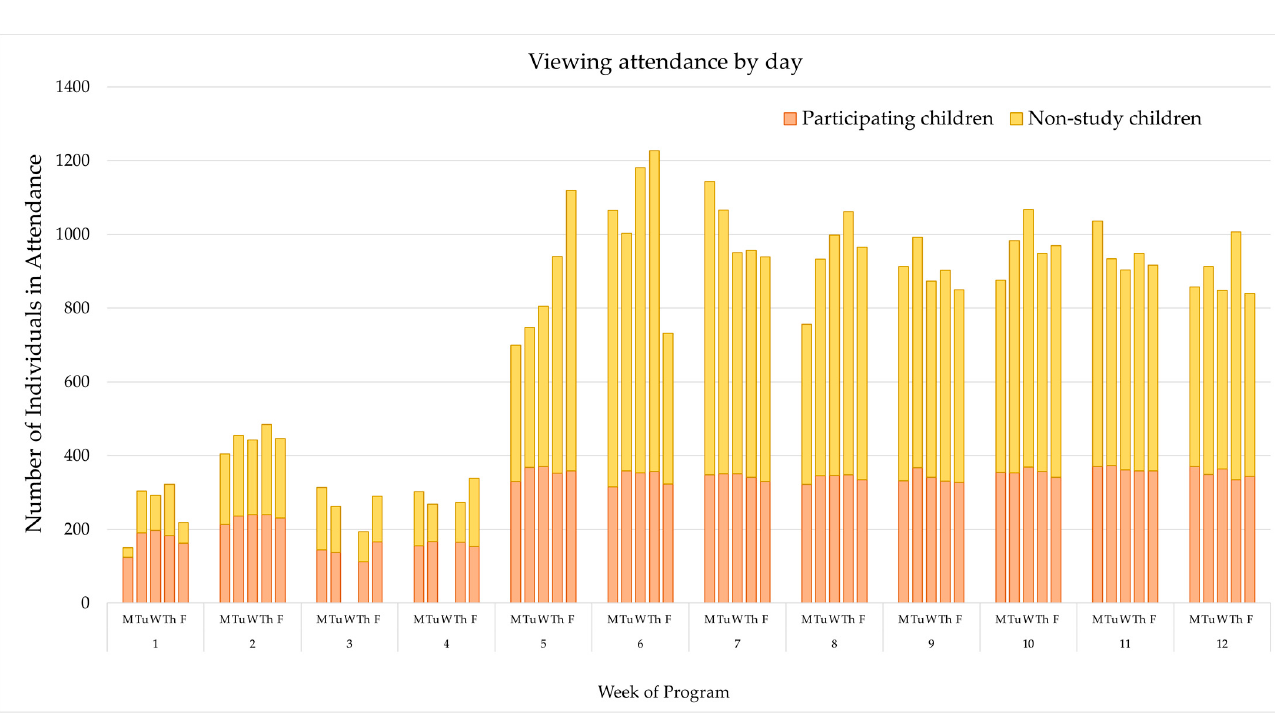
Figure A1. Akili and Me viewing attendance by day of week and week of intervention. Includes children participating and not participating in the study. M = Monday; T = Tuesday; W = Wednesday; Th = Thursday; F = Friday .